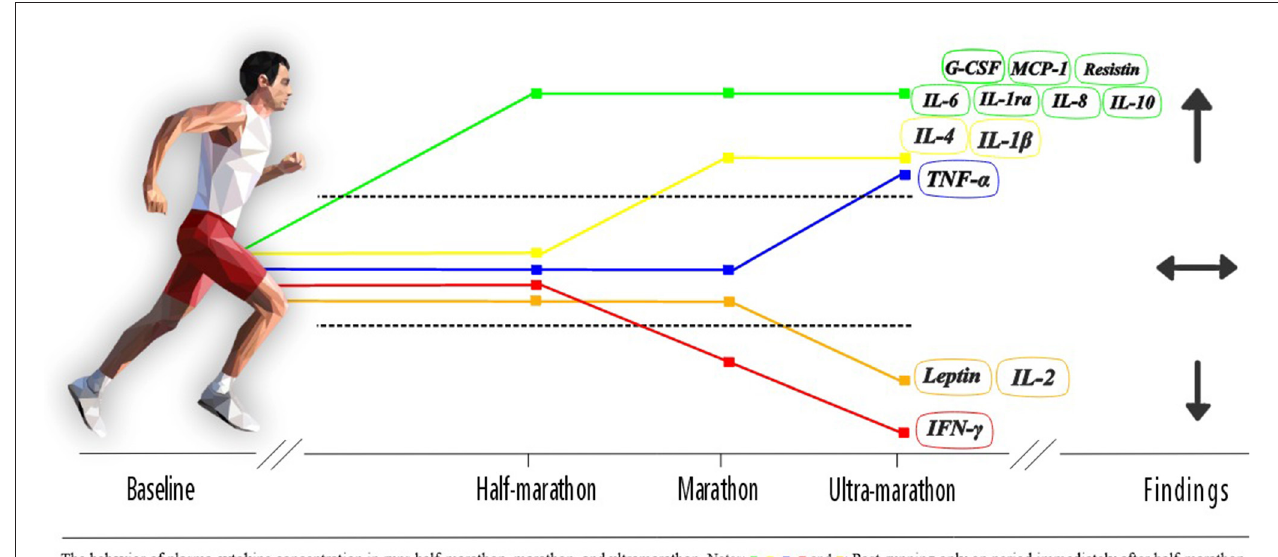
FIGURE 6 | Changes in cytokines concentration following long-distance running (Pngwing,